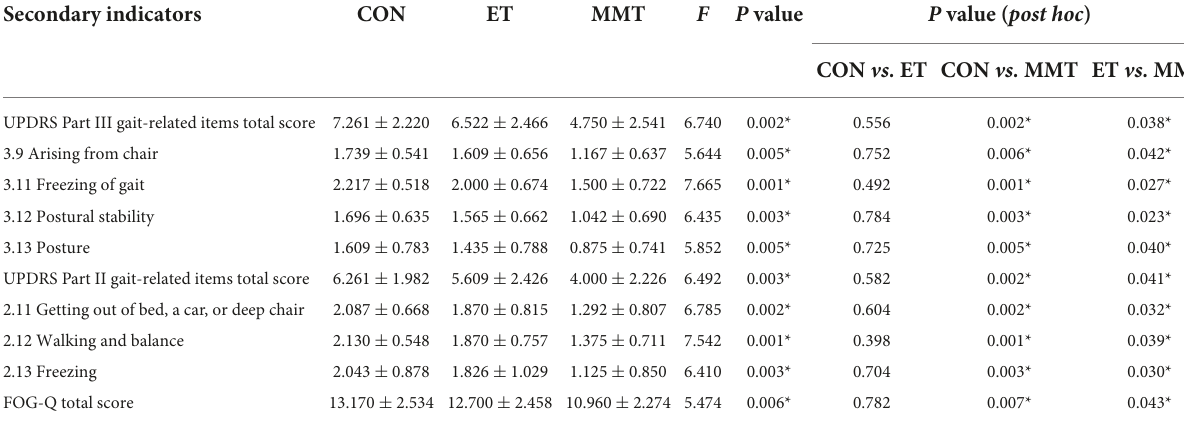
TABLE 3 Change in FOG-Q and the comprehensive motor function.